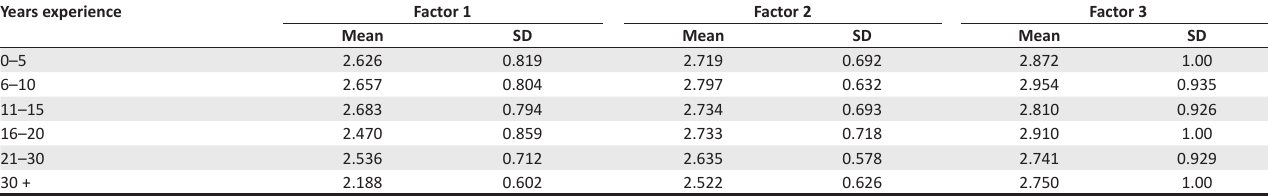
TABLE 15: Descriptive statistics for experience